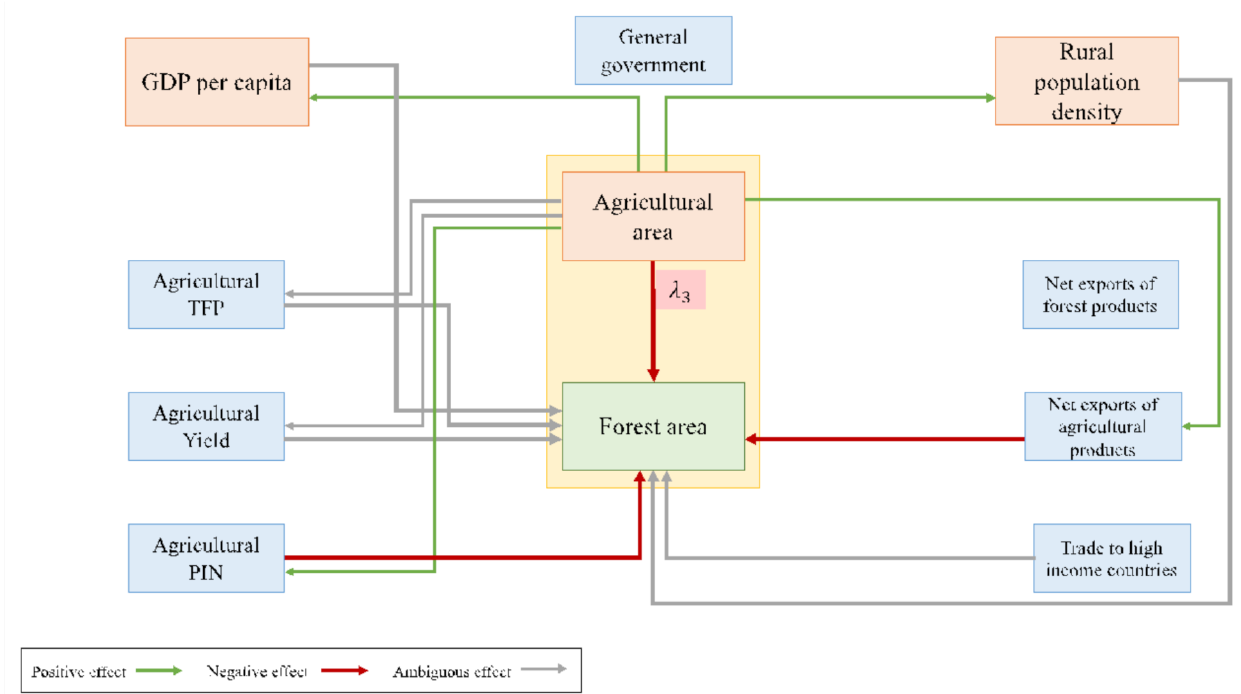
Figure A4. Estimating indirect effects of “Agricutural area”